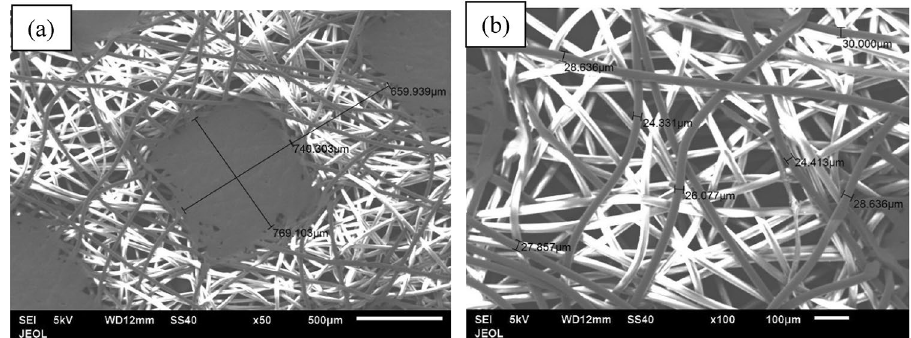
Figure 9. Fibers configuration of the first layer (blue) of the facemask; ( a ) showing the hollow square of the fibers and ( b ) the diameter of each fiber magnified 100 times.